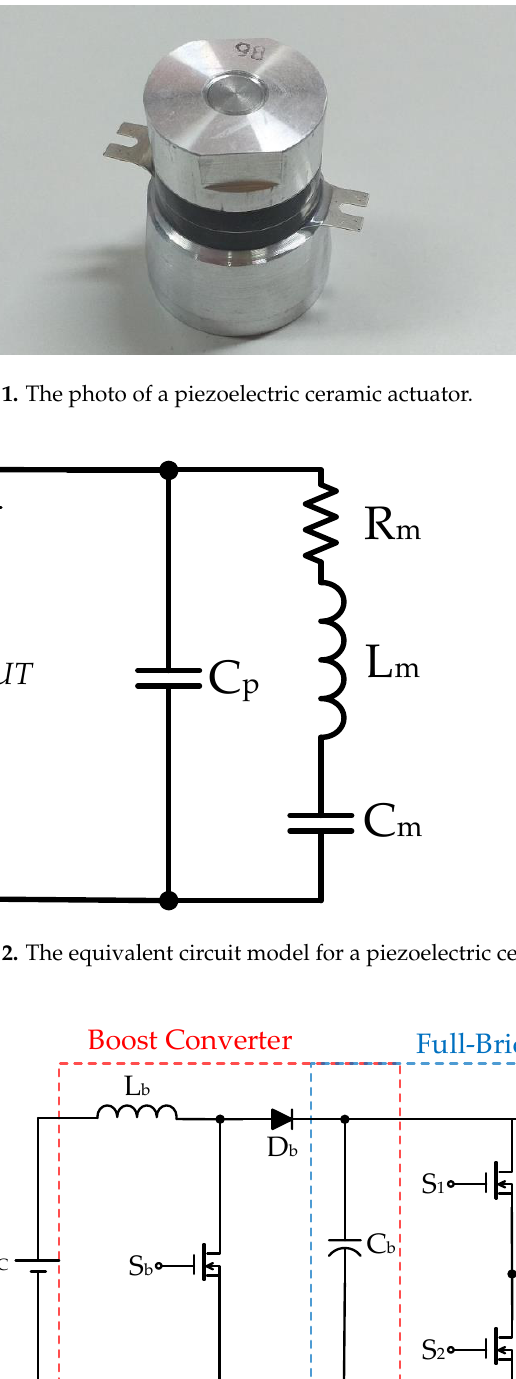
Figure 1. The photo of a piezoelectric ceramic actuator.